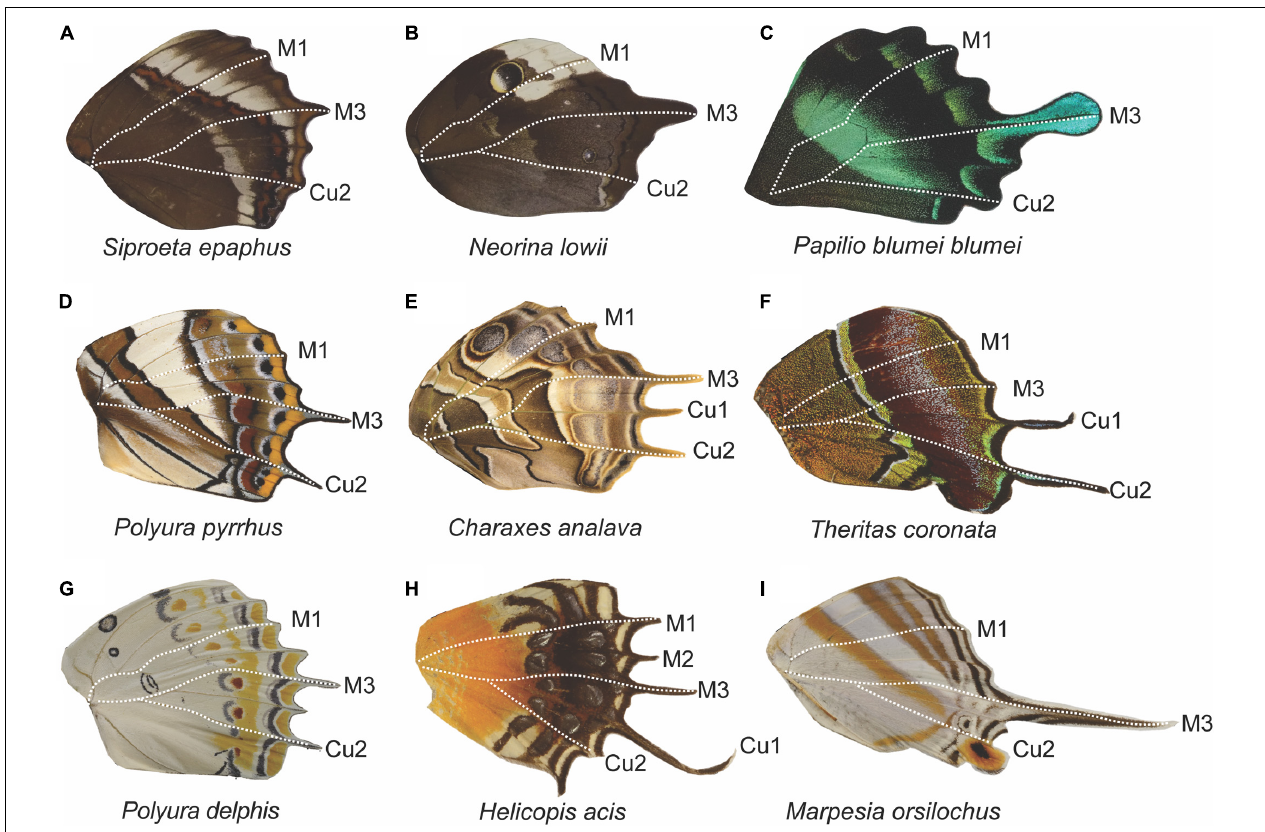
FIGURE 9 | Tail diversity across butterfly families and their correspondence to domain boundaries. Across butterfly taxa, tails most frequently occur at the M3 vein position and posterior to it as seen in nymphalids (A,B,D,E,G,I) , a papilionid (C) , and a lycaenid (F) . There are few instances of wings with projections at M1 and M2, as seen in the riodinid (H) . The absence of tails above M3 is most likely due to biomechanical constraints. Frequently, wings that display tails also have a scalloped distal margin (exemplified in C ), with most of the veins extending beyond the intervein region, compared to smooth distal wing margin in species where tails are absent (see Figure 6 , wings B,E,I,J,L